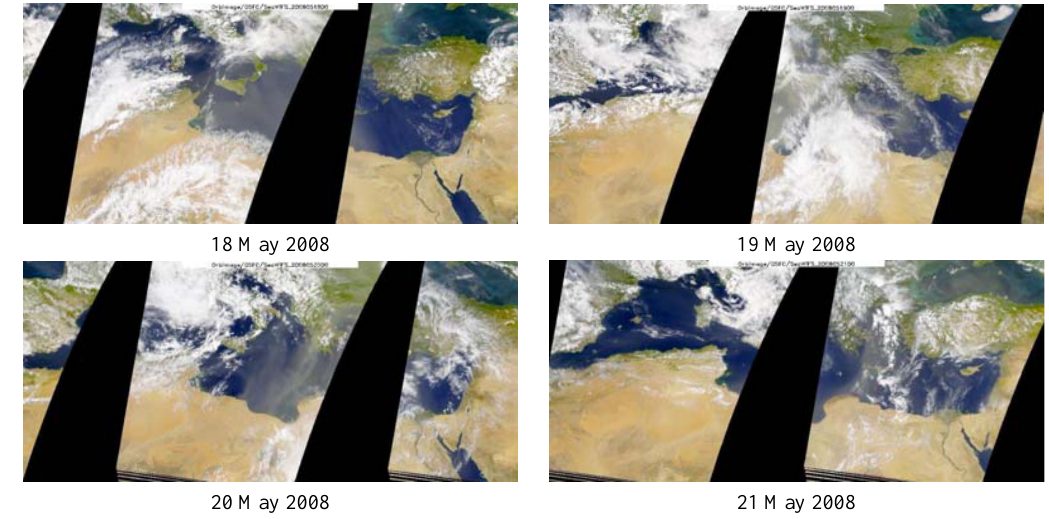
Fig. 2. SeaWIFS visible satellite images for 18, 19, 20 and 21 May 2008.